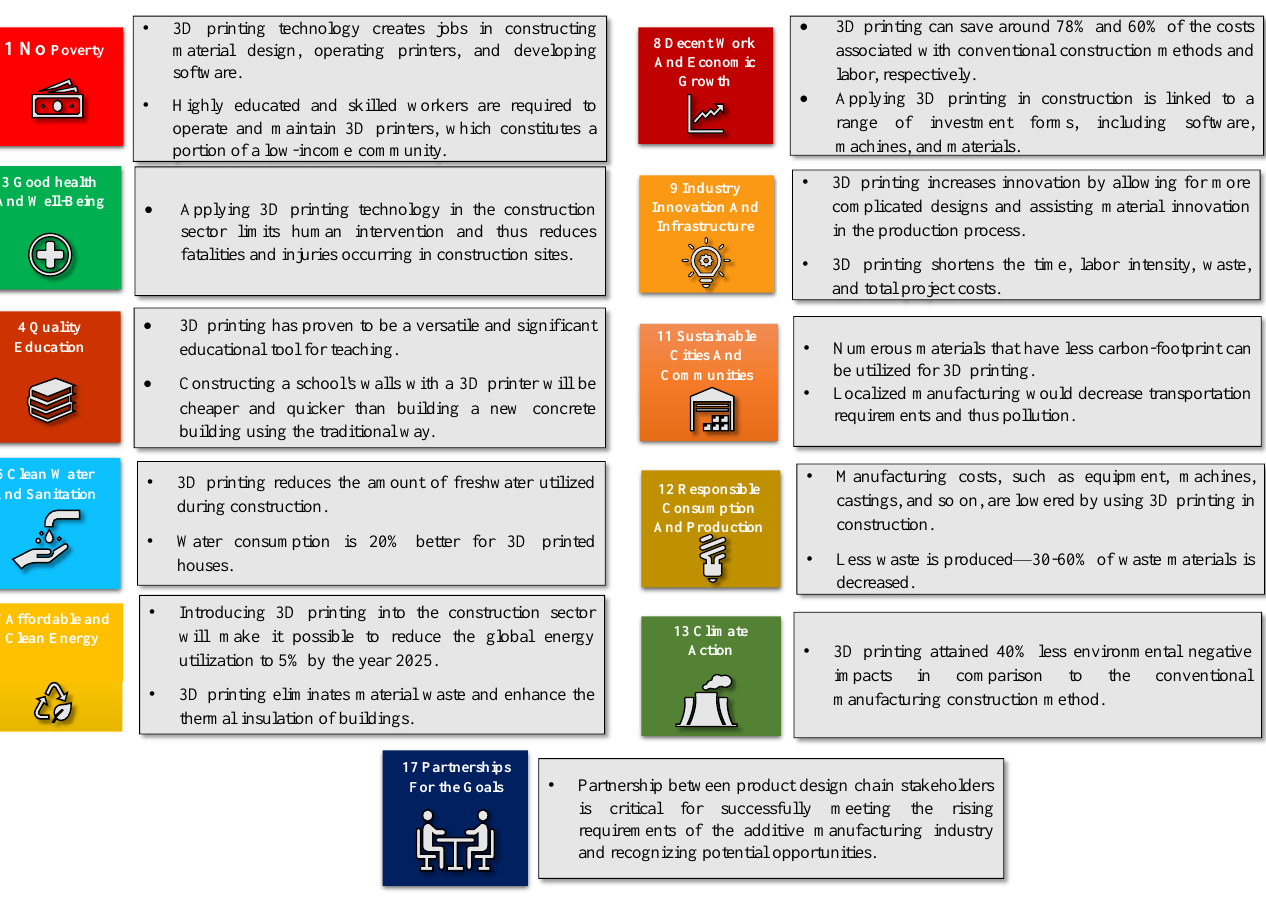
Figure 6. Summary of 3DCP impact on SDGs.